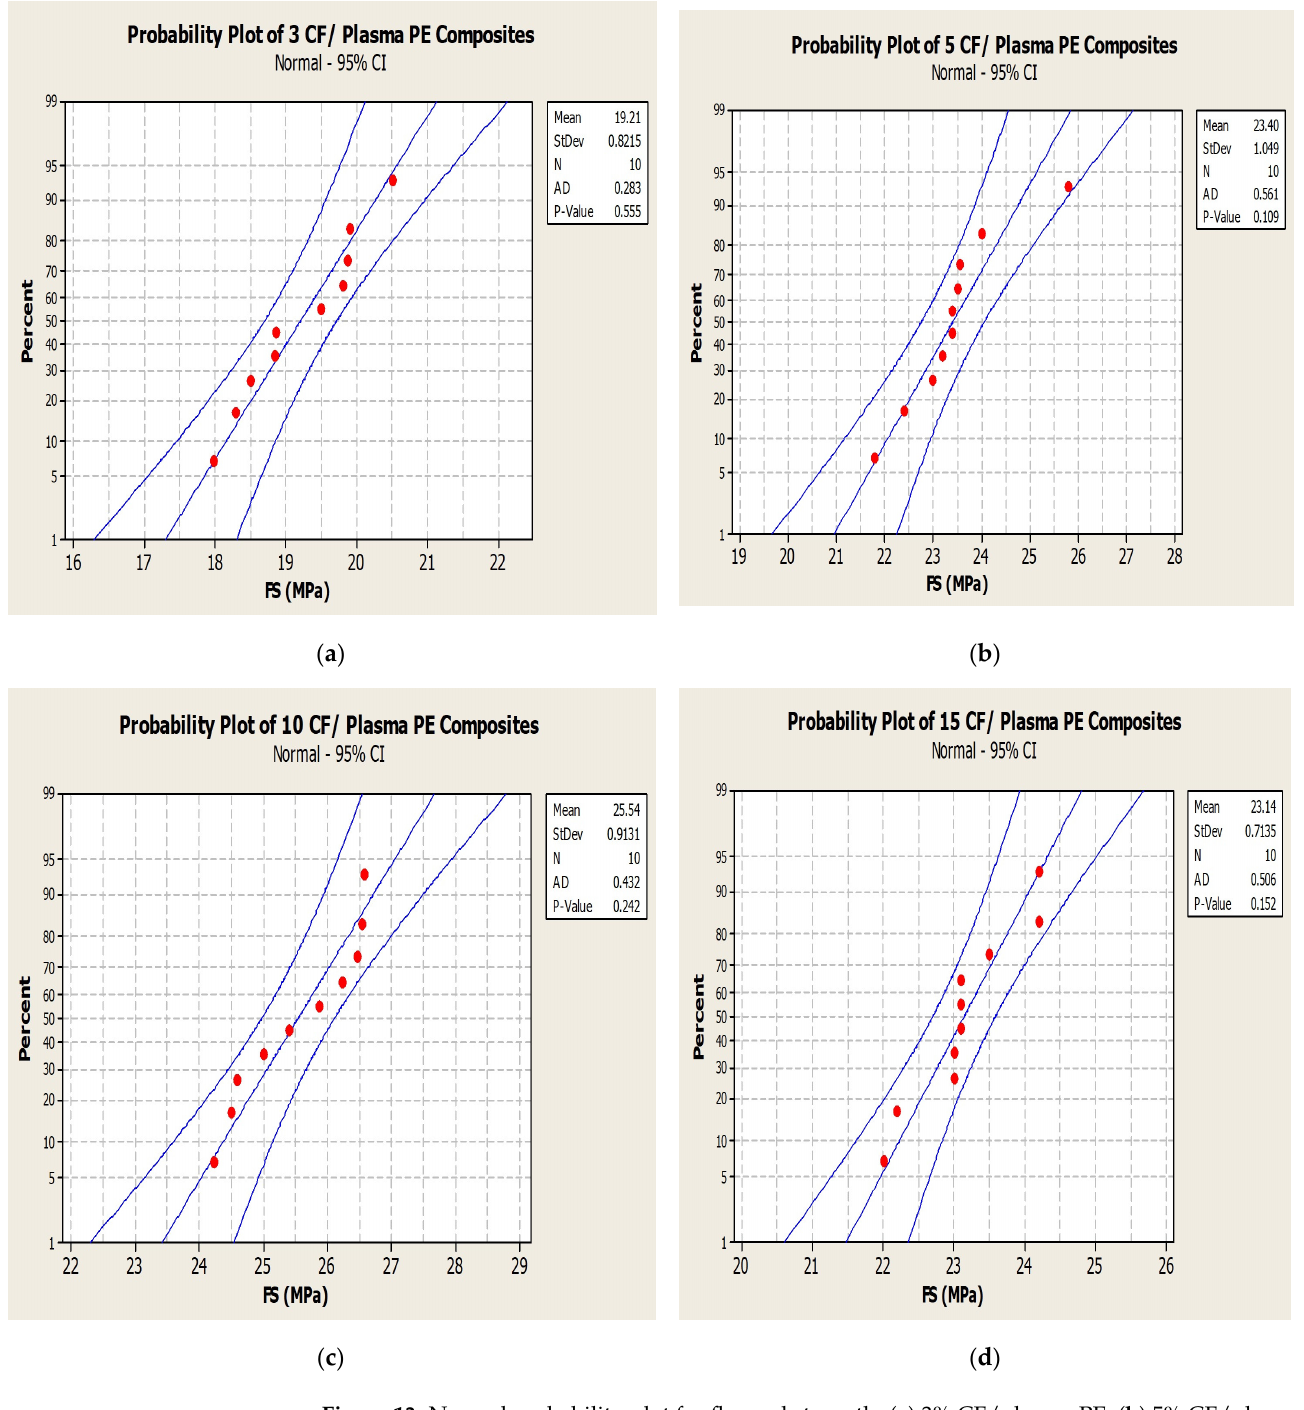
Figure 13. Normal probability plot for flexural strength: ( a ) 3% CF/plasma PE, ( b ) 5% CF/plasma PE, ( c ) 10% CF/plasma PE and ( d ) 15% CF/plasma PE combinations.